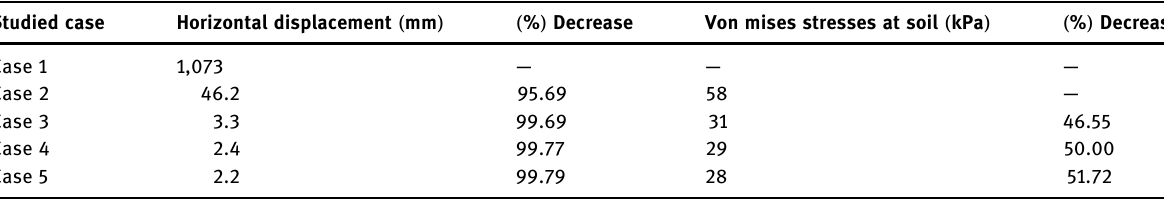
Table 4: Comparison between fi ve cases Studied case